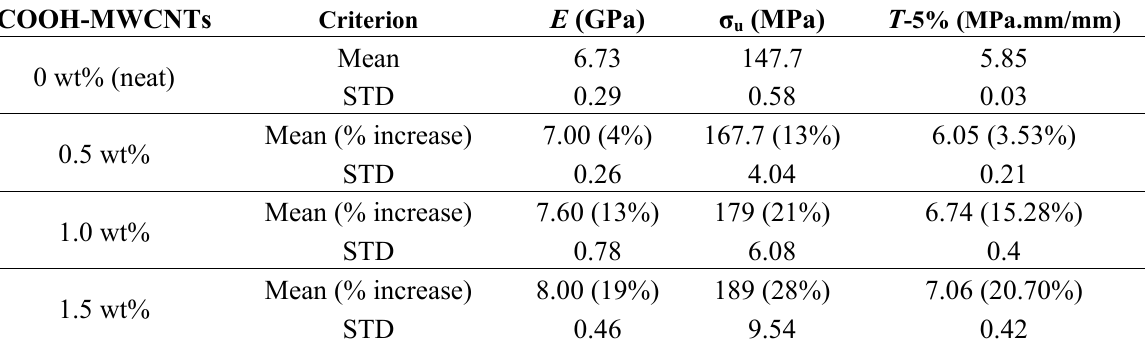
Table 3. Statistical analyses for the off-axis flexure test with various MWCNTs loadings: flexure modulus of elasticity ( E ), flexure strength (σ level ( T